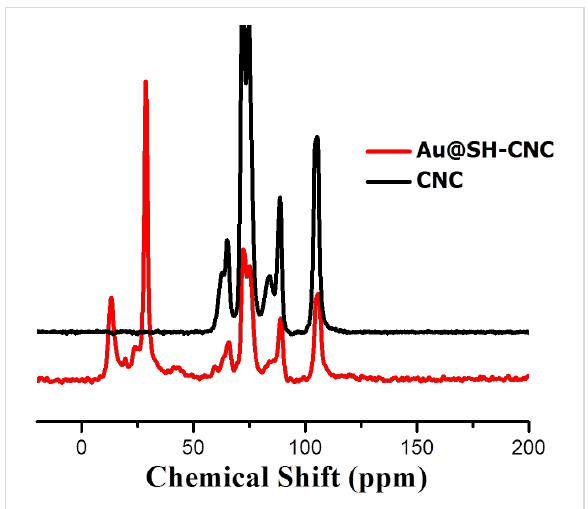
Figure 5: Solid-state 13 C NMR spectra of the CNC and Au@HS-CNC (4.4 mol %) catalyst.